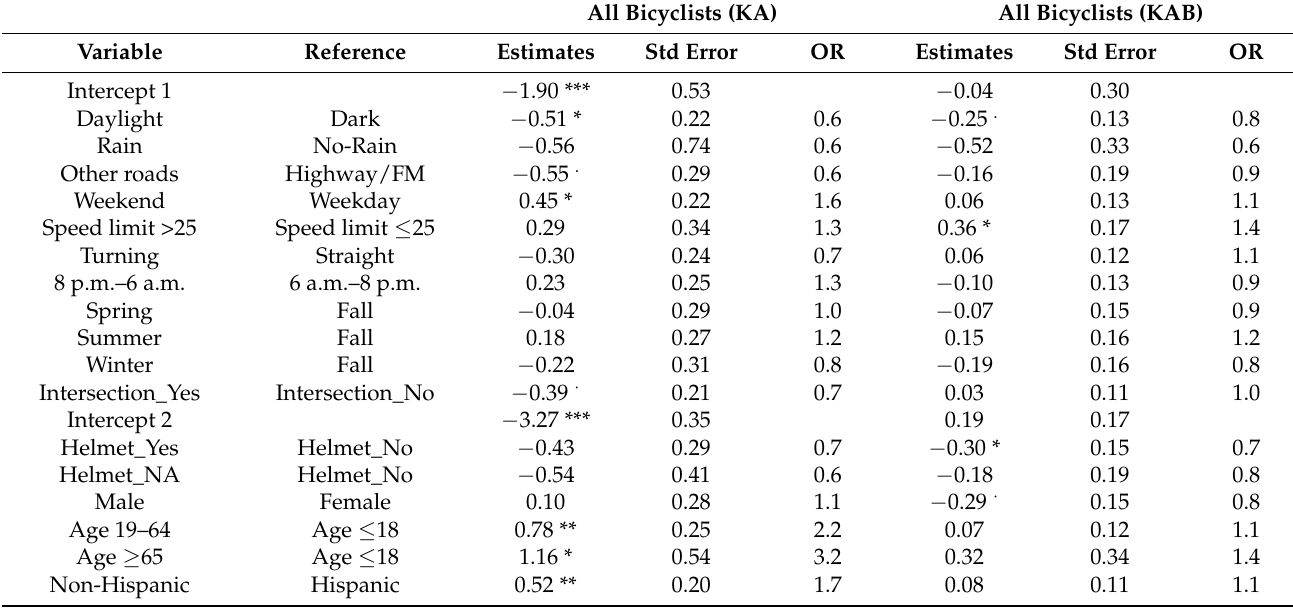
Table 4. Logistic regression model results for KA and KAB crashes. All Bicyclists (KA) All Bicyclists (KAB)